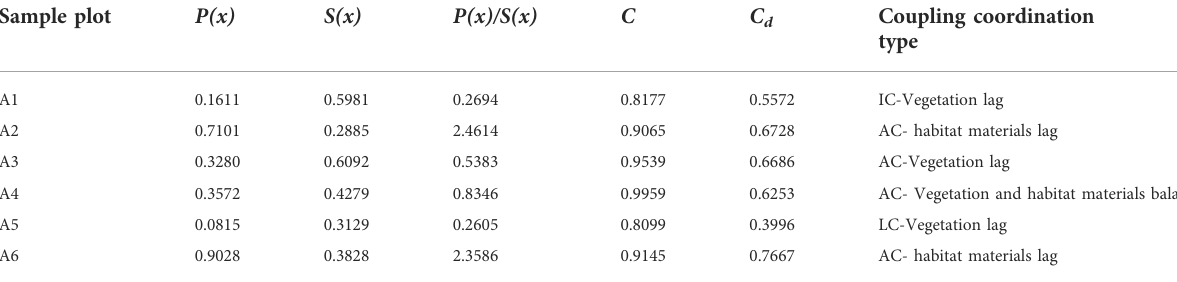
TABLE 4 Coupling coordination of habitat materials and vegetation system in different areas. Sample